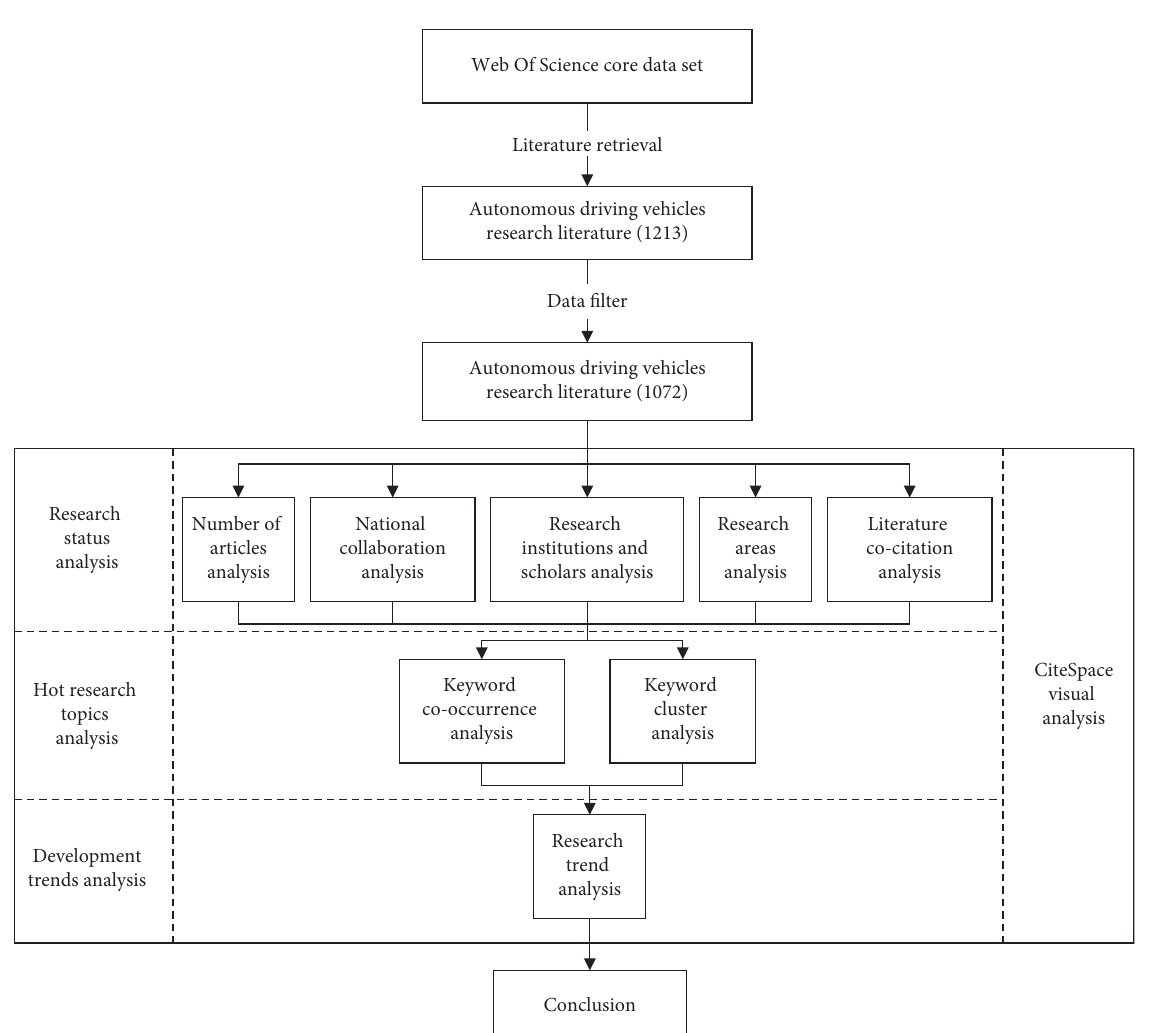
Figure 2: Framework of this